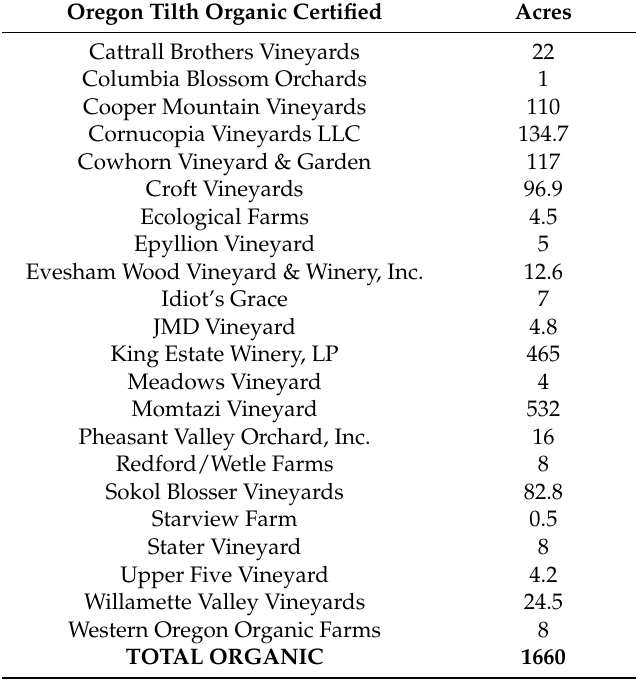
Table 1. Oregon’s Organic Vines (Adapted from [8], with permission from Oregon Organic Wine,